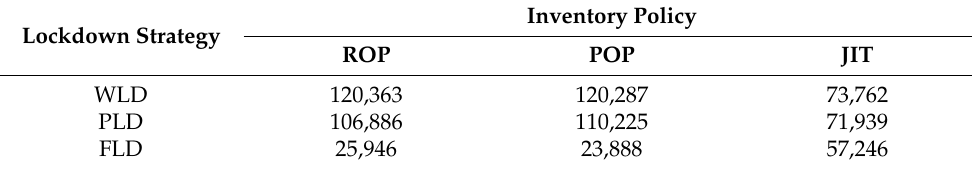
Table 3. Total inventory management cost.